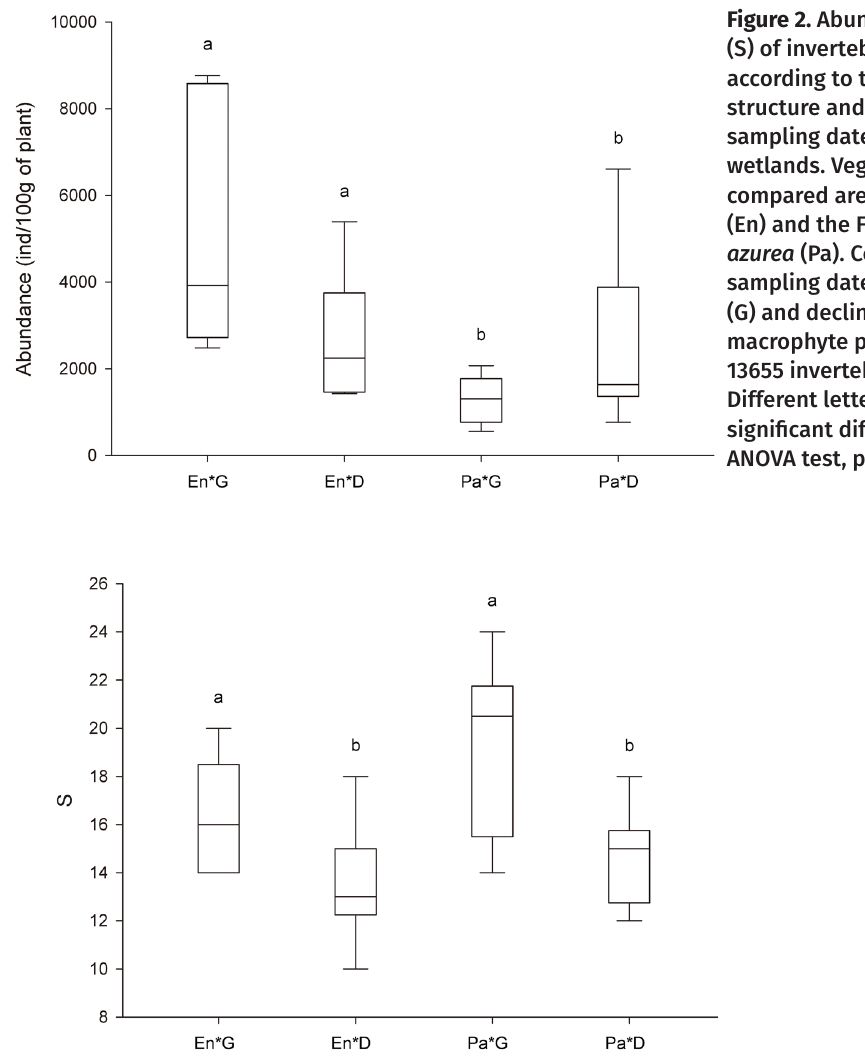
Figure 2. Abundance and richness (S) of invertebrate communities according to the vegetation structure and contrasting sampling dates at the Iberá wetlands. Vegetation structures compared are the S Egeria najas (En) and the FR Pontederia azurea (Pa). Contrasting sampling dates included growth (G) and decline (D) periods of macrophyte populations. N= 13655 invertebrates, 24 samples. Different letters indicate significant differences with ANOVA test,